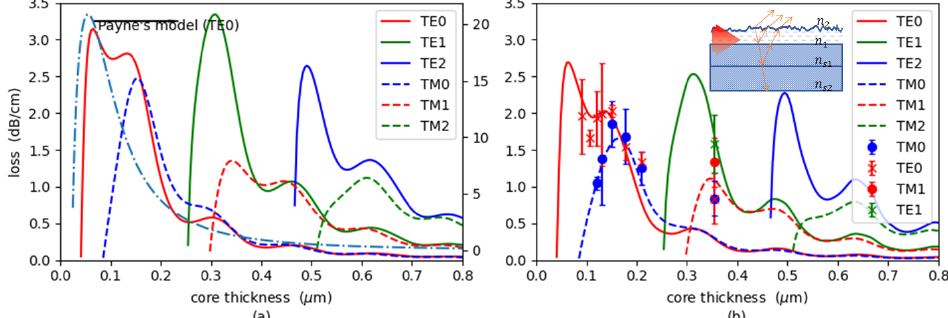
Fig. 1 Theoretical scattering loss coefficient for (a) three-layer air - 𝑇𝑎 2 𝑂 5 core - 𝑆𝑖𝑂 2 , planar waveguide (the dash-dot line is scattering loss from Payne ’ s model that omits the interference effect – plotted on the right Y-axis). (b) four-layer structure and the experimental results (the silica substrate layer is 2µm thick). The operation wavelength is